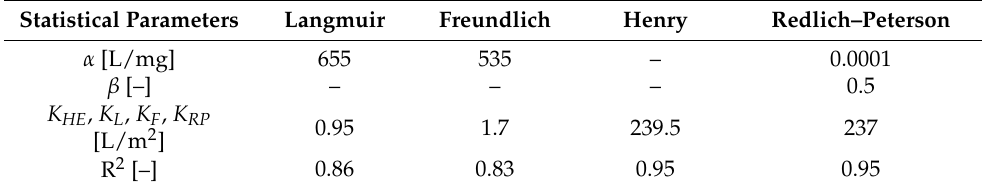
Table 3. Isotherm coefficients and fit statistics for Langmuir, Freundlich, Henry and Redlich–Peterson isotherms. ( α = isotherm constant, β = exponent that lies between 0 and 1, K = constants for different isotherms, R 2 = coefficient of